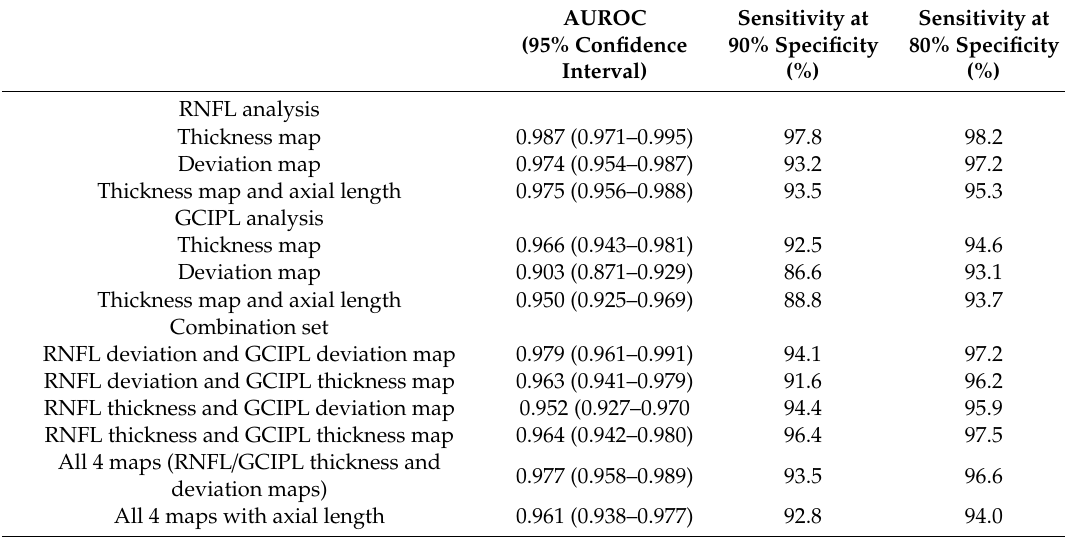
Table 3. Diagnostic ability of deep learning system for diagnosing glaucoma based on retinal nerve fiber layer (RNFL) and ganglion cell–inner plexiform layer (GCIPL) spectral-domain optical coherence tomography maps when testing the internal validation